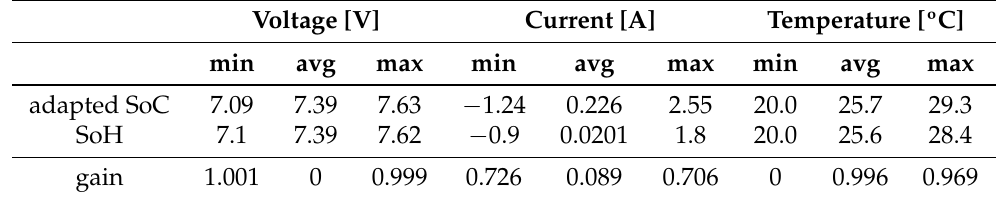
Table 8. Battery 3 during a month of simulation: Case 1.